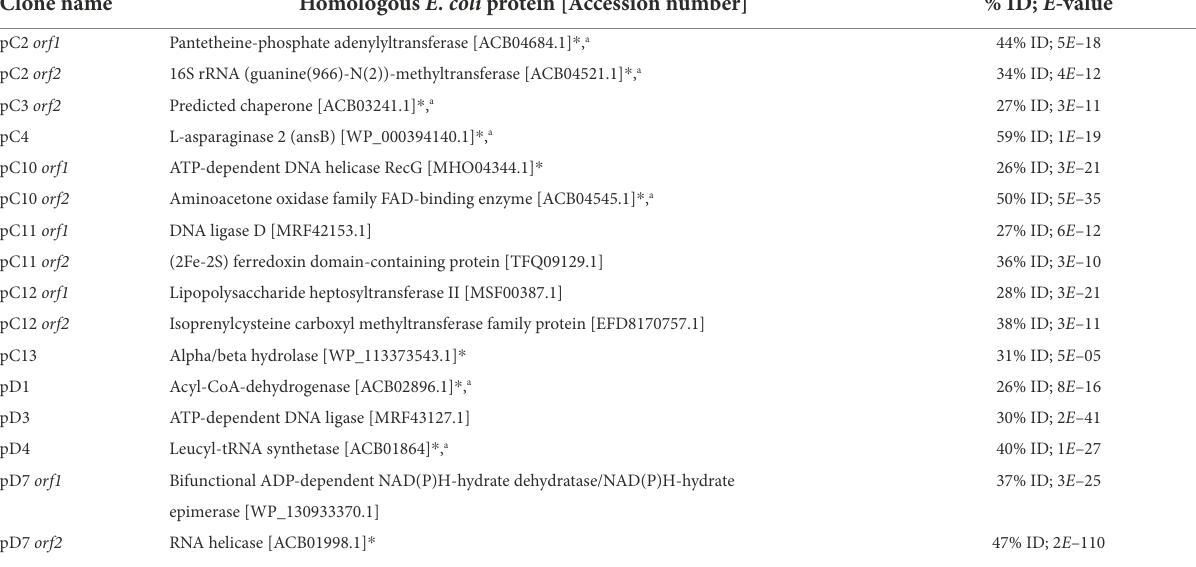
TABLE 2 Escherichia coli proteins homologous to cold-tolerant proteins encoded by the genes isolated from Antarctic metagenomic